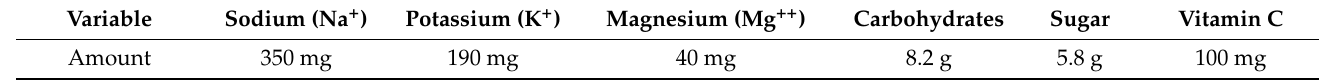
Table 1. 3RINK nutrition components (Based on 1 sachet [10